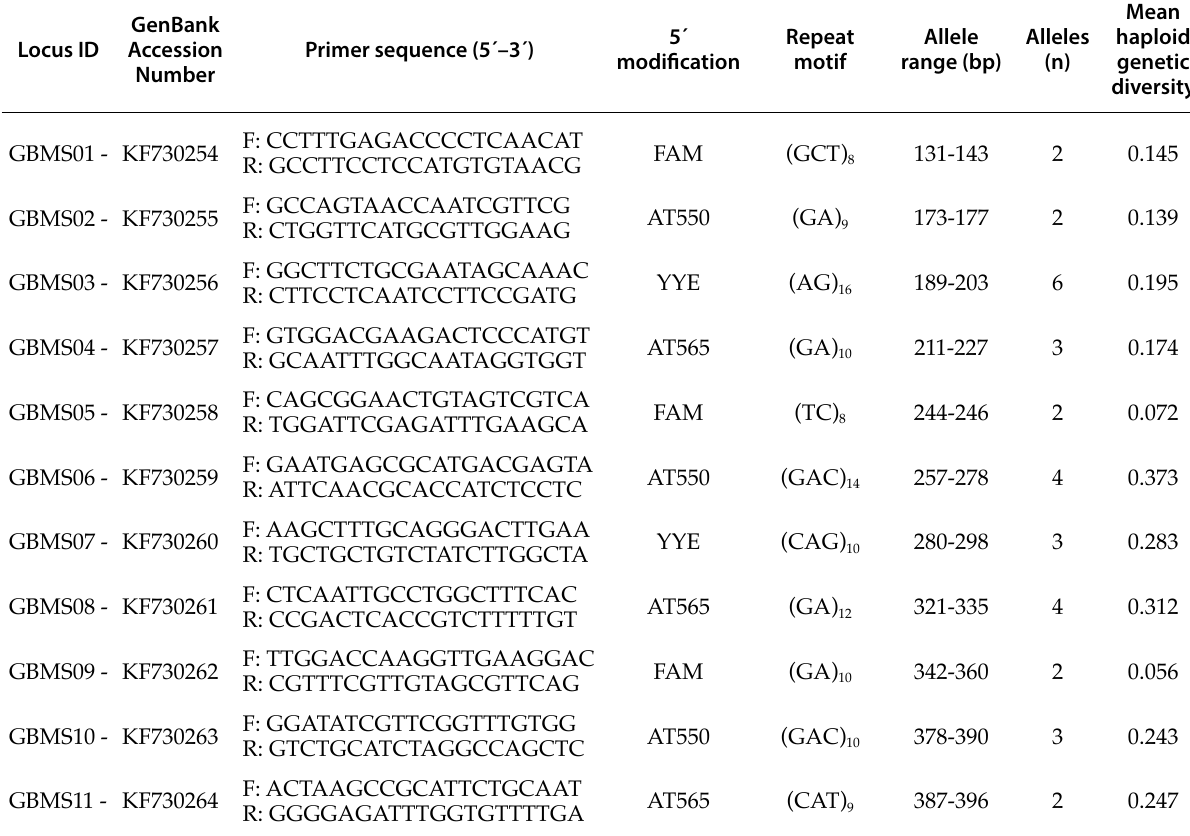
Table 3. Primers amplifying microsatellite markers developed for the characterization of Phyllosticta ampelicida . Locus